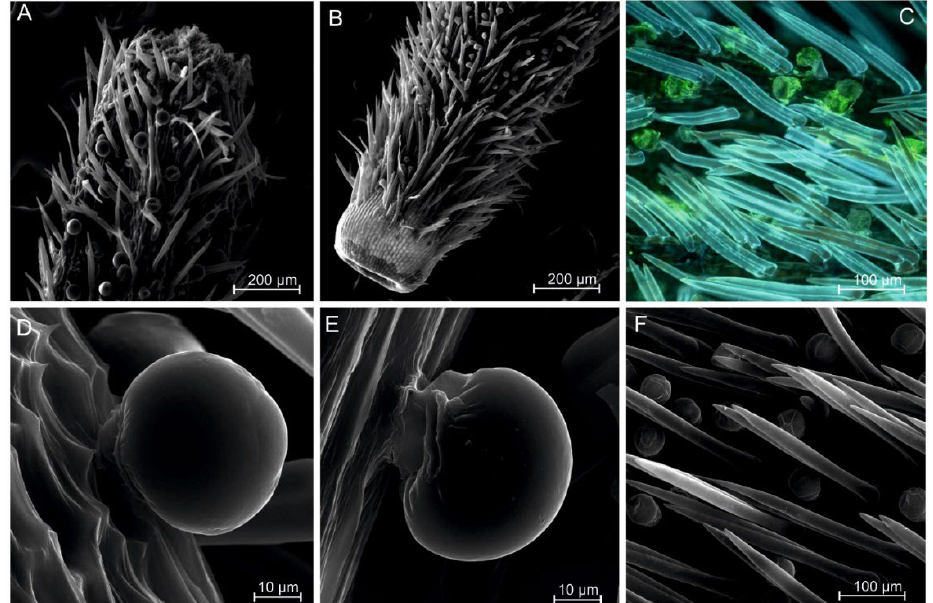
Figure 2. Micromorphology of the surface of arnica achenes from two zones: distal ( A ) and proximal ( B ). Two types of trichomes on the pericarp surface observed in FM. Lignin shows blue autofluores- cence in two-celled, sharp-edged non-glandular trichomes, while glandular trichomes emit green fluorescence indicating the presence of cellulose ( C ). Two morphological and functional types of trichomes covering the pericarp: sharp-edged, elongated non-glandular trichomes and spherical glandular trichomes ( F ). Two-celled glandular trichomes composed of a stalk attached to the pericarp wall and a large spherical apical cell ( D , E ).